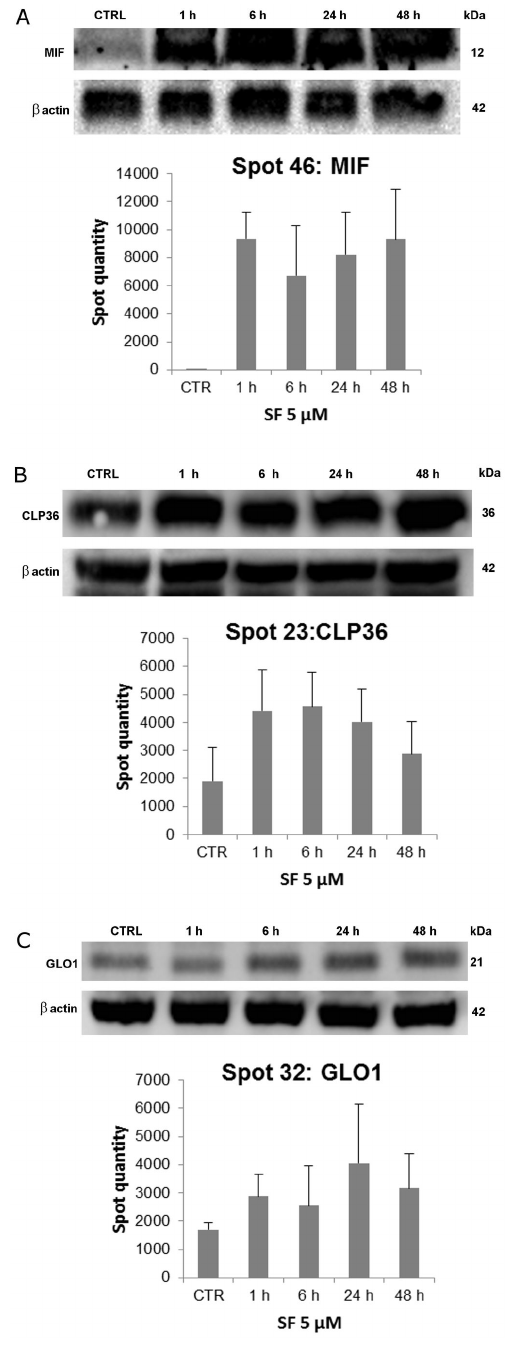
Figure 4. Validation of MS results by immunoblotting. Cardiomyocytes were treated with 5 μM SF for 1-48 h followed by western blot analysis for MIF ( A ), CLP36 ( B ), and GLO1 ( C ). Representative bands and raw densitometric values of the corresponding protein spots from proteomic analysis are shown. Each bar represents the spot quantity as determined by PDQuest (mean ± SD). At least three biological replicates with two technical replicates were run for each tested